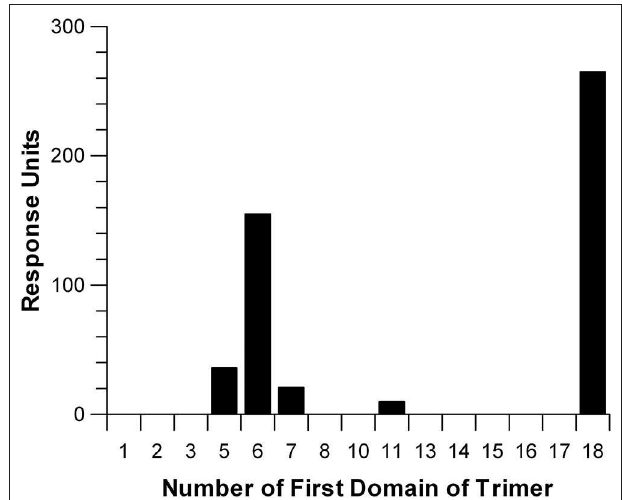
FIGURE 7 | Relative affinity of three-domain Factor H fragments for heparin. Recombinant three-domain fragments of Factor H were injected over a sensor chip coated with heparin which was attached through a single amino group incorporated at the reducing end of the polysaccharide chain. This yields heparin with a single orientation and with all sulfate groups intact. The SPR measurements shown are the result of injecting each fragment at a concentration of 3 µ M in HBS-P over the heparin-coated surface. Individual sensorgrams for each three-domain fragment are shown in Supplemental Figure 1 .